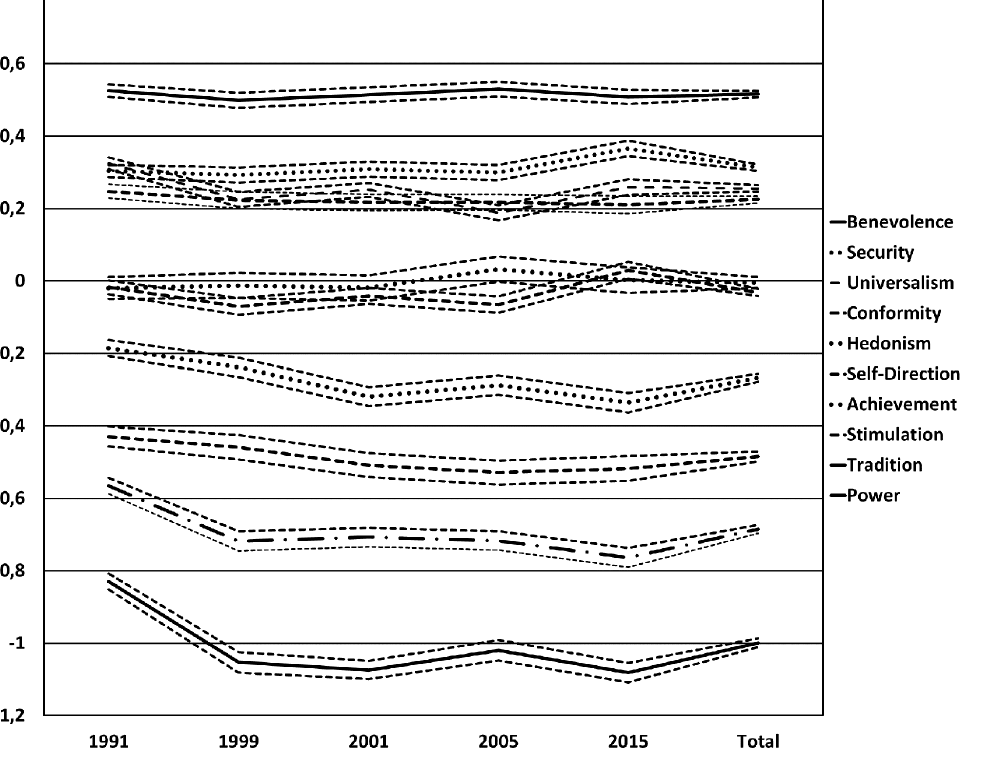
Figure 4. Changes in the centered scores of the ten basic values in Finland in 1991-2015. The dense dashed lines indicate the 95% confidence level of value